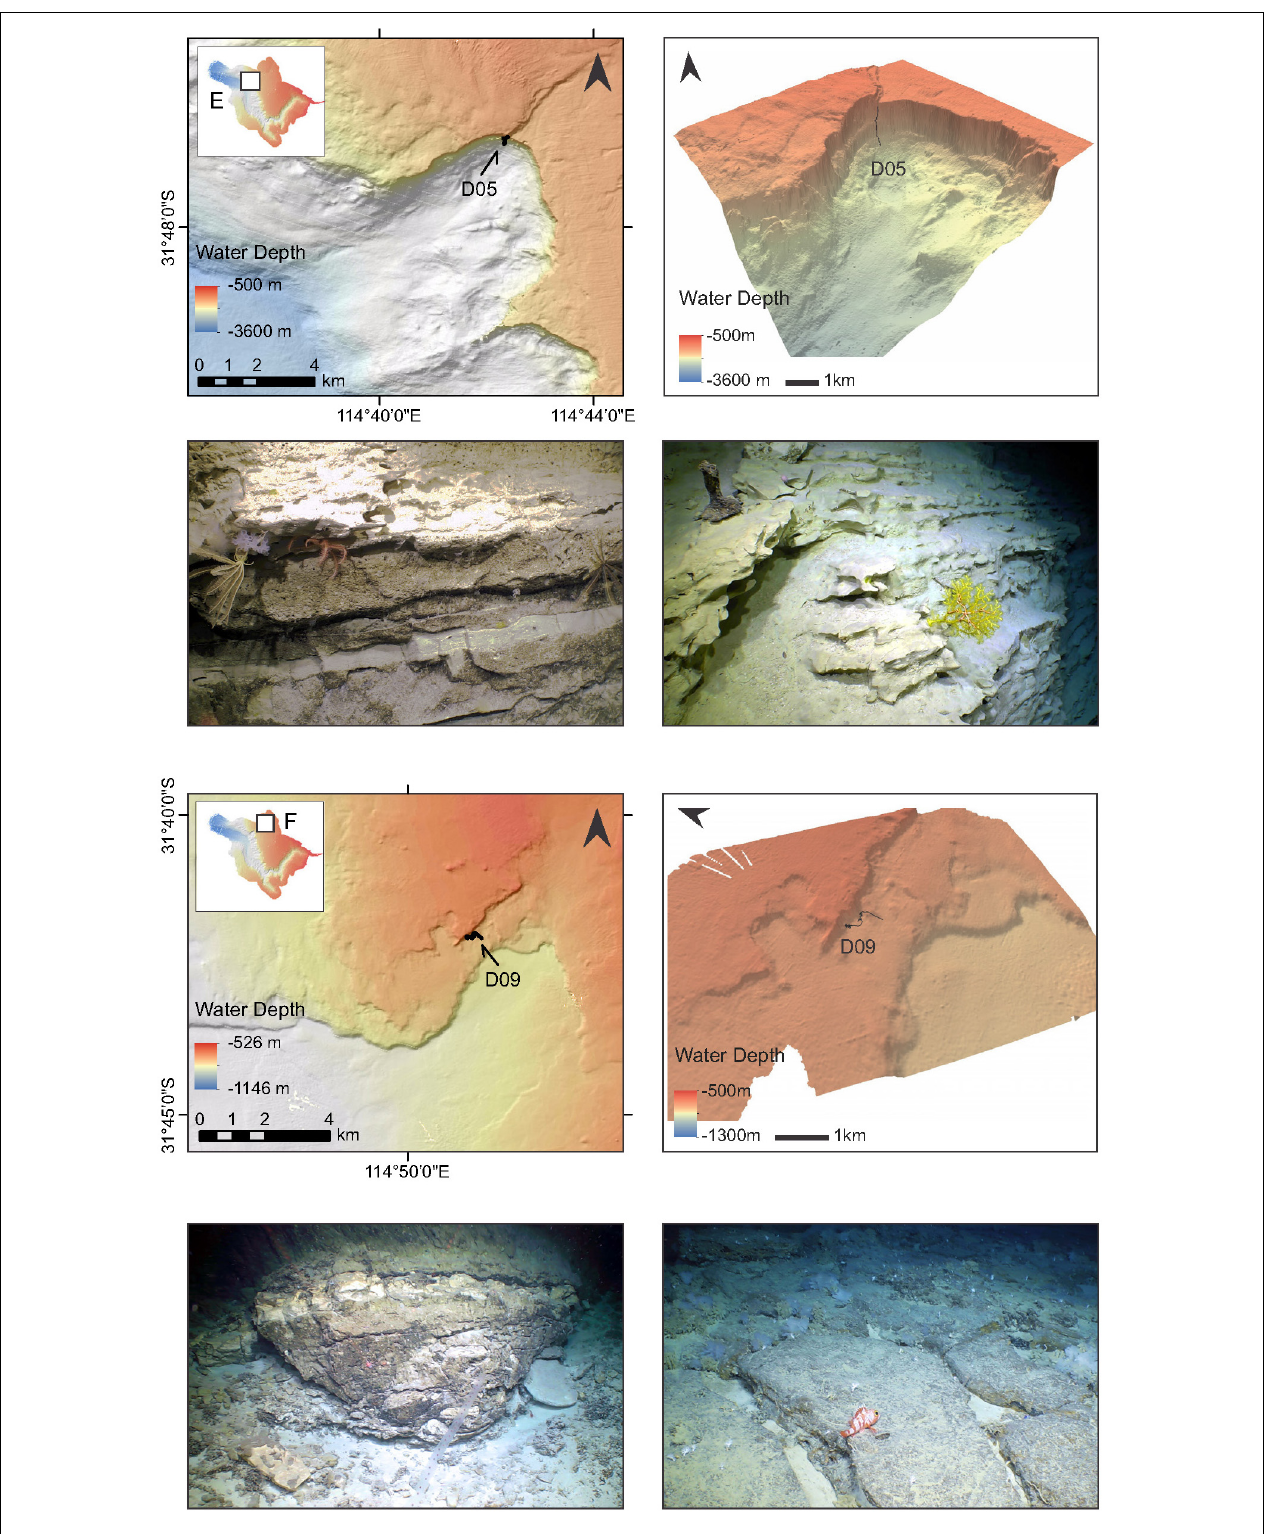
FIGURE 4 | High-resolution bathymetry maps and photos of lithologies of the canyon walls and substrates at ROV dive Sites E and F (note insets), located in the western region of the canyon system. Black lines on the bathymetry maps depict ROV tracks, with each dive number indicated.